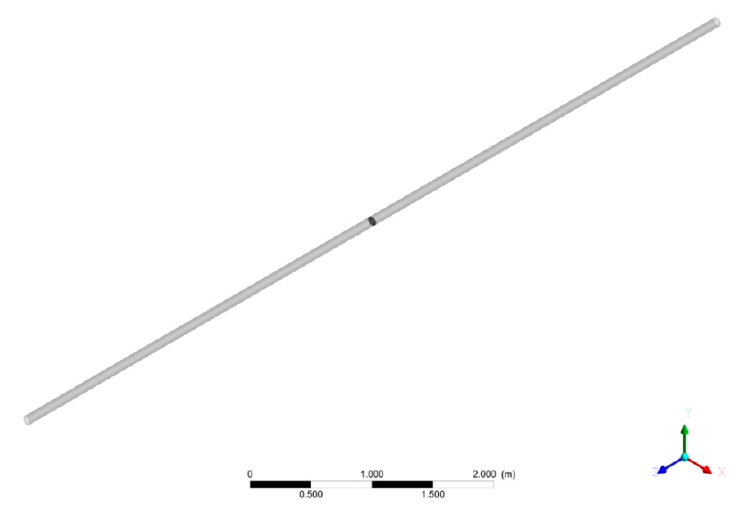
Figure 3. Geometry of the computational domain: the second version.